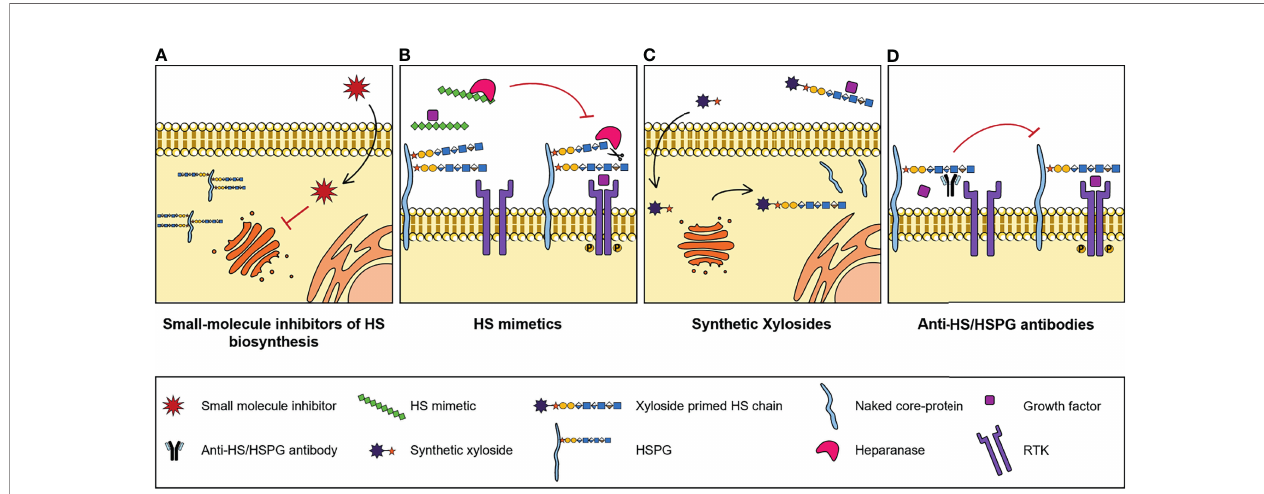
FIGURE 3 | Illustrative representation of the mechanisms of action of four types of molecules developed to target HS biosynthesis and HS-protein interactions, with potential for cancer therapy: (A) Small-molecule inhibitors of HS biosynthesis. Cell-permeable, small-molecule compounds with inhibitory activity against GAG biosynthesis enzymes, that impair glycans ’ biosynthesis and sulfation. (B) HS mimetics. HS-like compounds that compete with HS chains for the binding of enzymes, like Heparanase, or HS-binding proteins, like growth factors, blocking HS-protein interactions and inhibiting the formation of important cell signalling complexes. (C) Synthetic xylosides. Synthetic primers for protein-free GAG biosynthesis, that interfere with the GAGosylation of native PGs ’ core protein, and when secreted into de extracellular environment, compete with endogenous GAGosylated PGs for the binding of biologically active ligands. (D) Anti-HS/HSPG antibodies. Antibody molecules developed to target HS and HSPGs and to inhibit HS-ligand interactions and downstream signalling